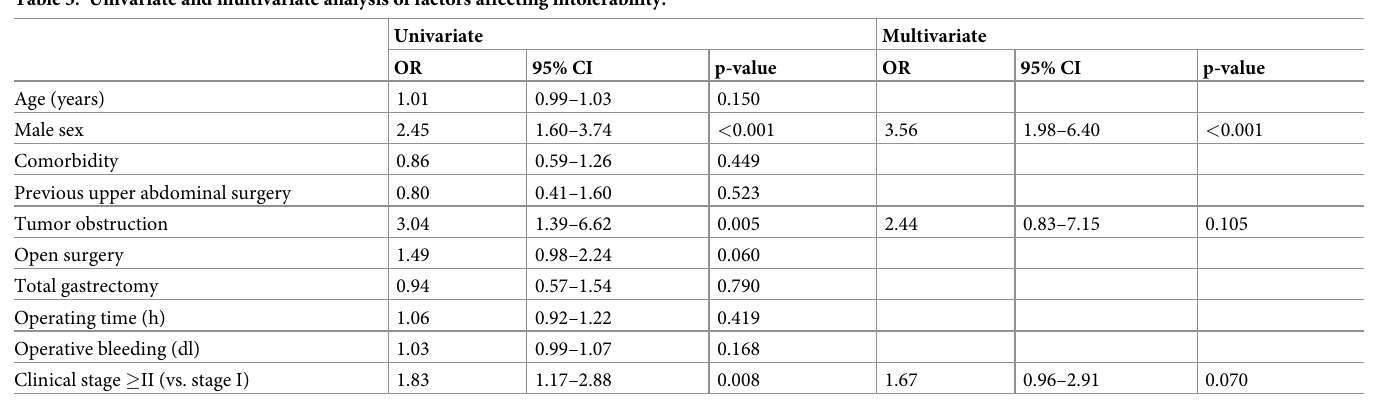
Table 3. Univariate and multivariate analysis of factors affecting